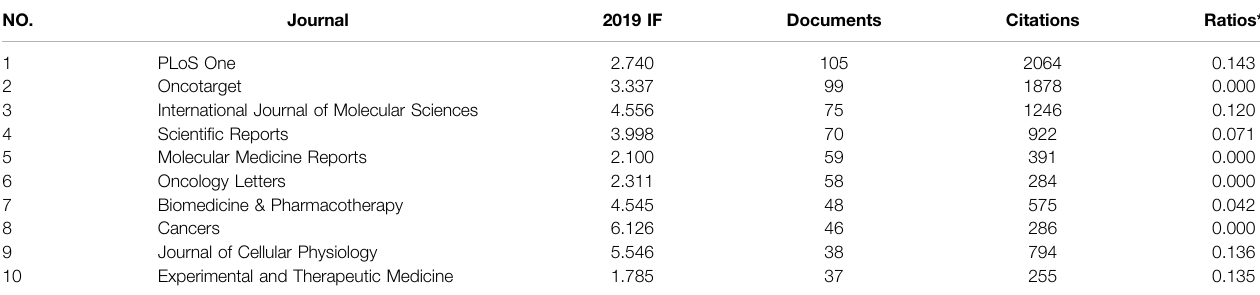
TABLE 3 | Top 10 journals with the largest number of documents. NO.